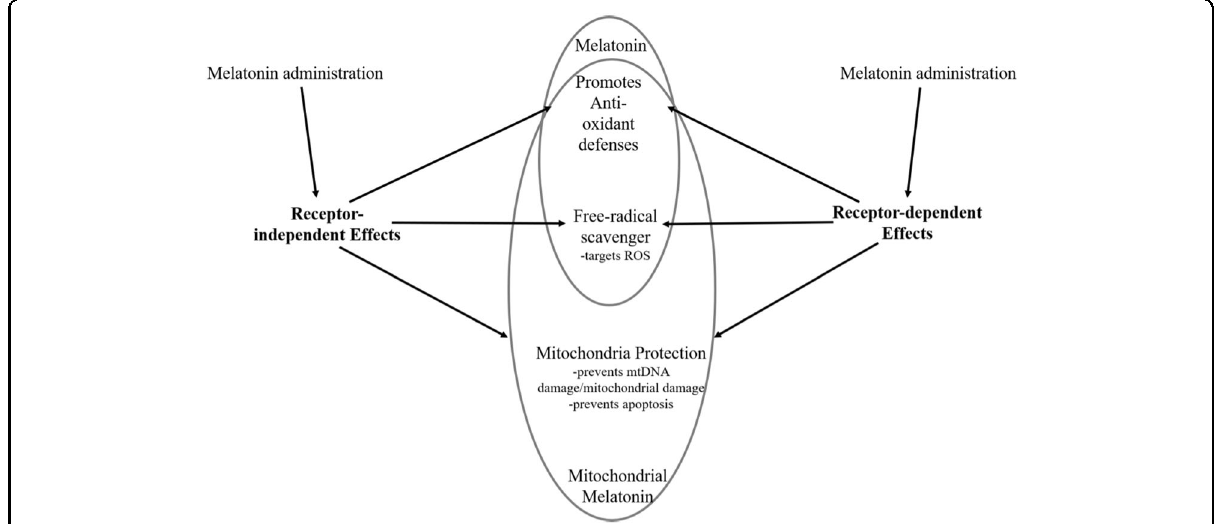
Fig. 1 Overview of melatonin receptor-independent and receptor-dependent neuroprotective effects. Melatonin administration can elicit receptor-independent and dependent effects. Melatonin promotes anti-oxidant defenses and free-radical scavenging throughout the body. The relatively high levels of melatonin within mitochondria have the important bene fi t of enhanced protection against mtDNA damage and prevention of